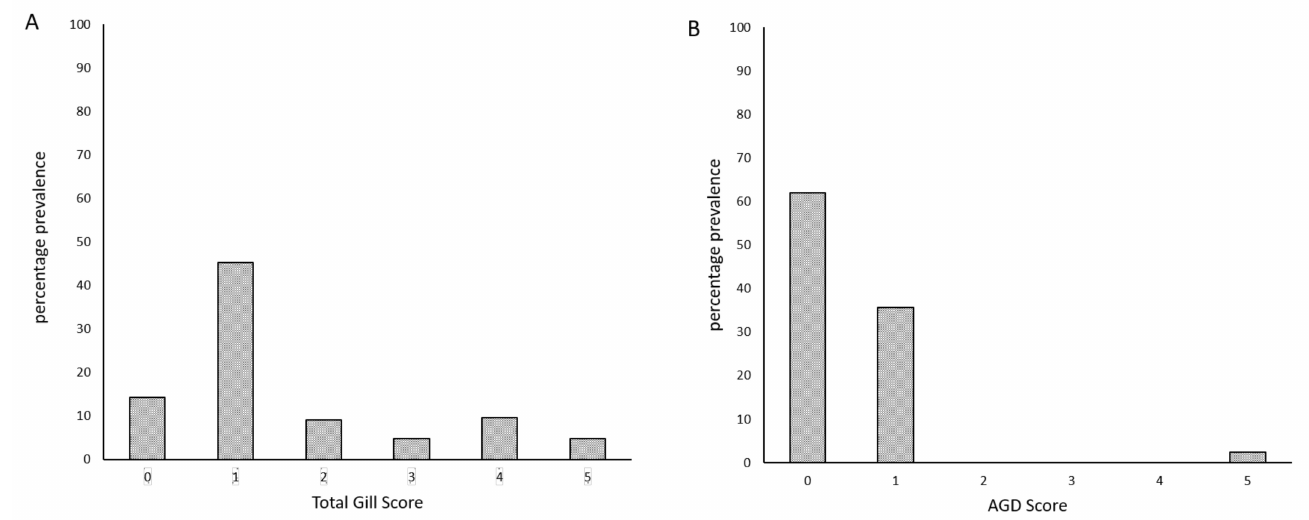
Figure 3. Percentage prevalence of ( A ) total gross gill scores and ( B ) AGD scores for lethally sampled fish ( n = 42).